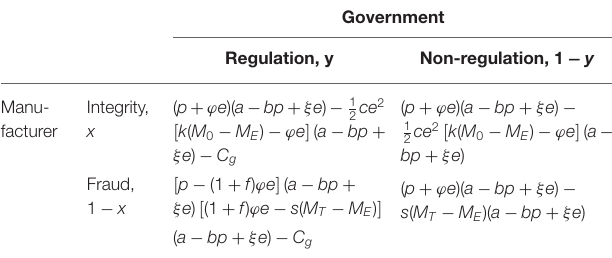
TABLE 2 | The payoff matrix for the government and the